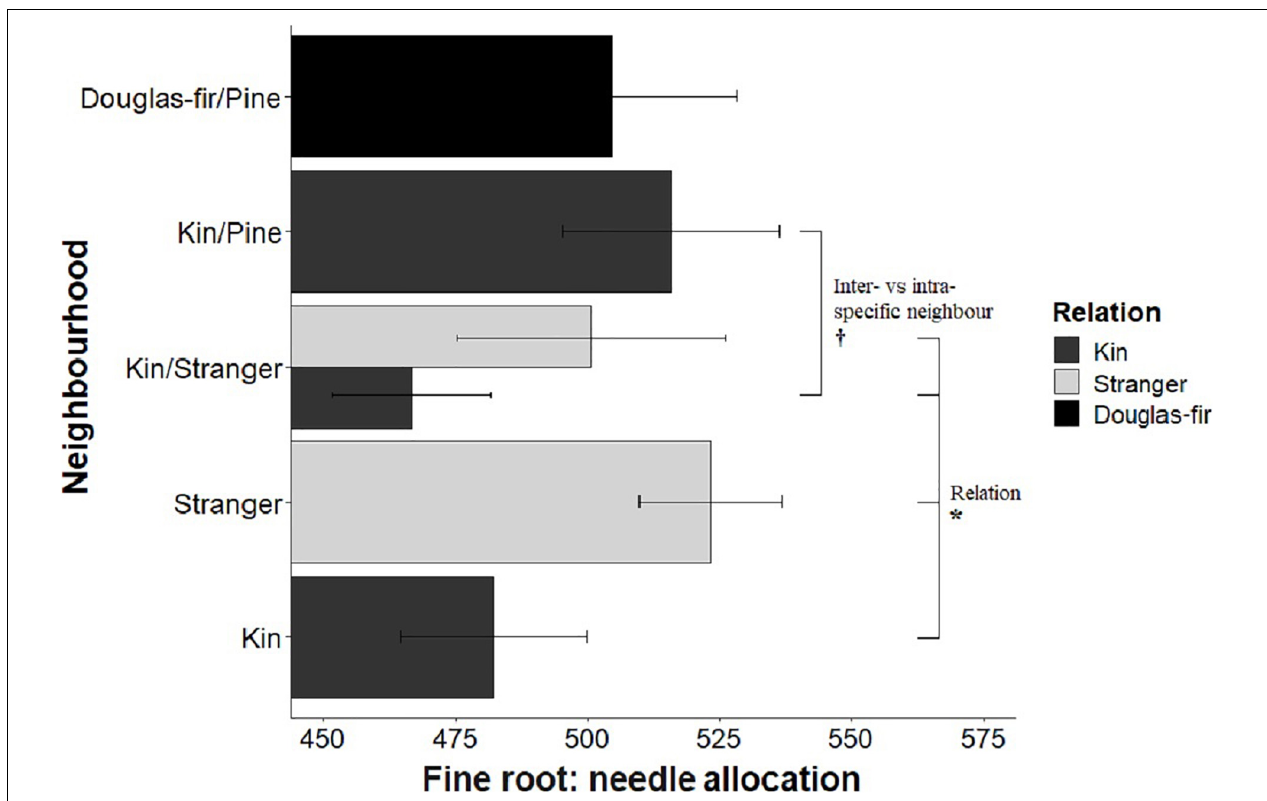
FIGURE 8 | Estimated marginal means from planned contrasts ( Table 2 ) relation (estimate = 74.9, t ratio = 2.03, p = 0.0437, Df = 193), stand (not significant), inter- vs. intraspecific neighbor (kin pair with intra- or interspecific as the neighbor) (estimate = 49.0, t ratio = 1.93, p = 0.0557, Df = 193) and presence and number of pine seedlings (not significant) on the different slopes linear model fine root: needle mass allocation: fine ∼ needle + Neighborhood × Family + needle: Neighborhood. * p < 0.05 and † p <